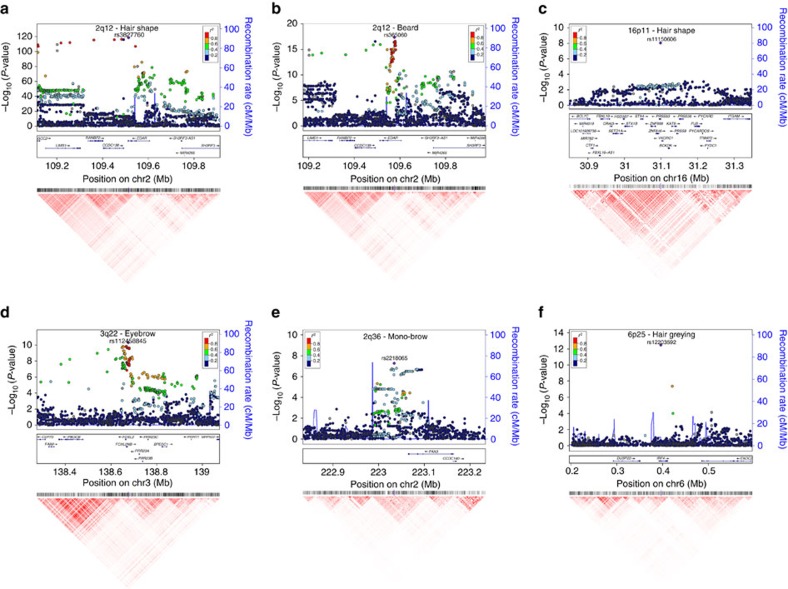
Association plots for six regions with SNPs showing genome-wide significant association to hair traits.(a) 2q12 hair shape, (b) 2q12 beard thickness, (c) 16p11 hair shape, (d) 3q22 eyebrow thickness, (e) 2q36 monobrow, (f) 6q25 hair greying. The index SNP in each region (Table 1) is shown as a purple diamond. At the top of the figure are shown the association results (on a -log10
P scale; left y axis) for all genotyped and imputed SNPs. The dot colour indicates the strength of LD (r2) between the index SNP and each SNP (based on the 1000genomes AMR data set). Recombination rate across the region, in the AMR data, is shown as a continuous blue line (scale on the right y axis). Genes in the region are shown in the middle. These plots were produced using LocusZoom68. Below each LocusZoom plot we show an LD heatmap (using r2, red indicating r2=1 and white indicating r2=0) produced using Haploview69. Coordinates used are from human genome sequence build 37. Plots for regions not shown here are presented in Supplementary Fig. 8.